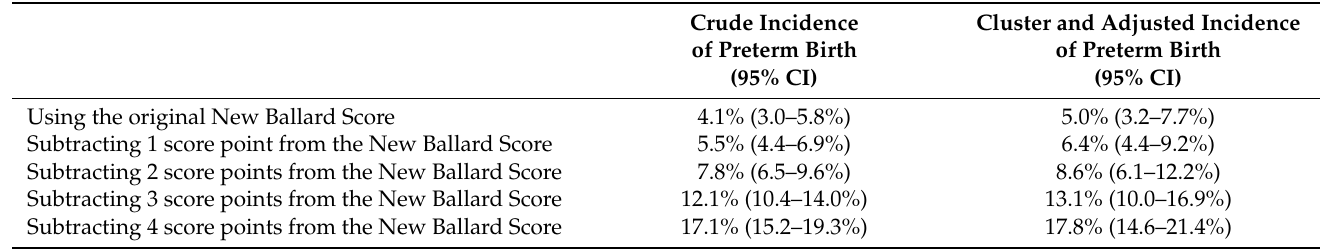
Table 2. Sensitivity analysis of the incidence of preterm birth based on the New Ballard among 1279 infants in Northern Uganda.